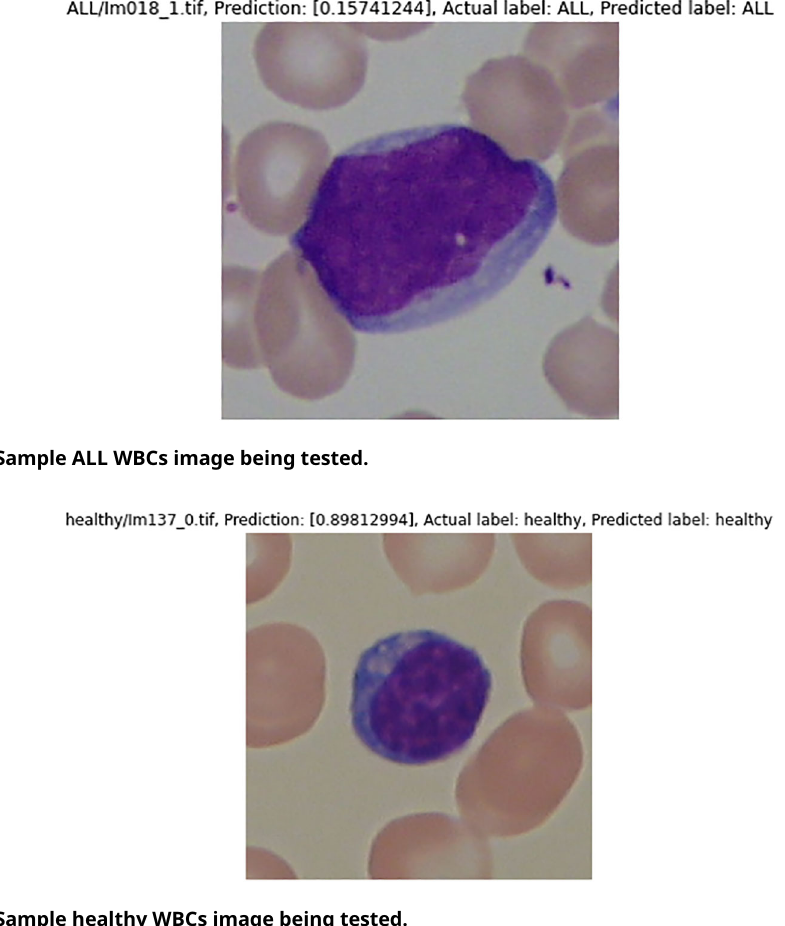
Figure 17. Sample healthy WBCs image being tested.